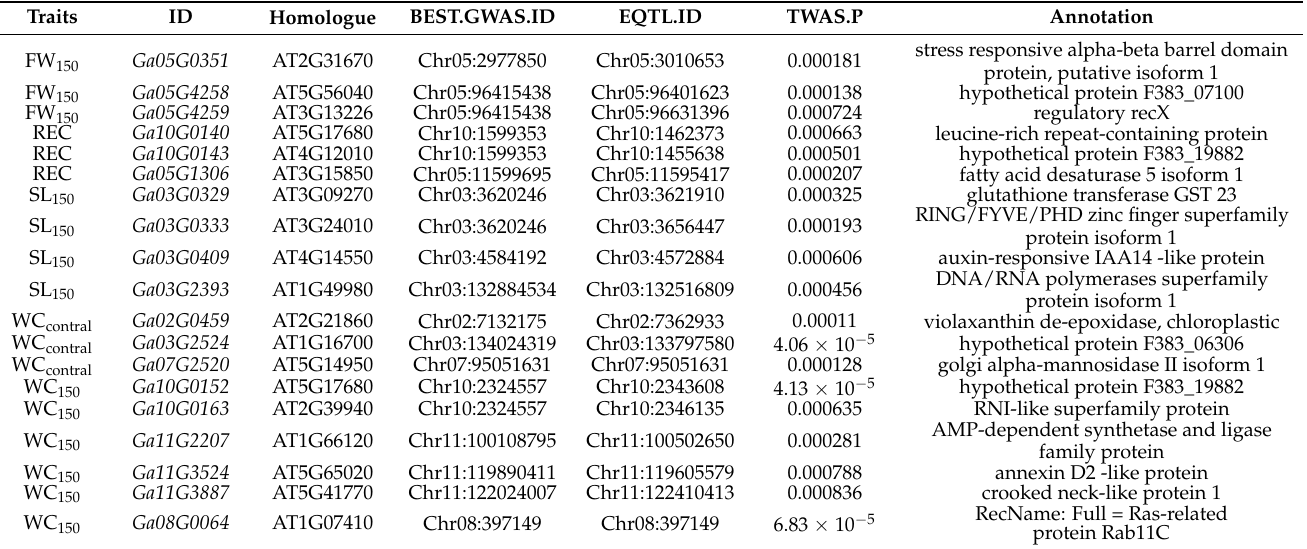
Table 1. Identification of significant gene-trait associations in Gossypium arboreum using transcriptome-wide association study